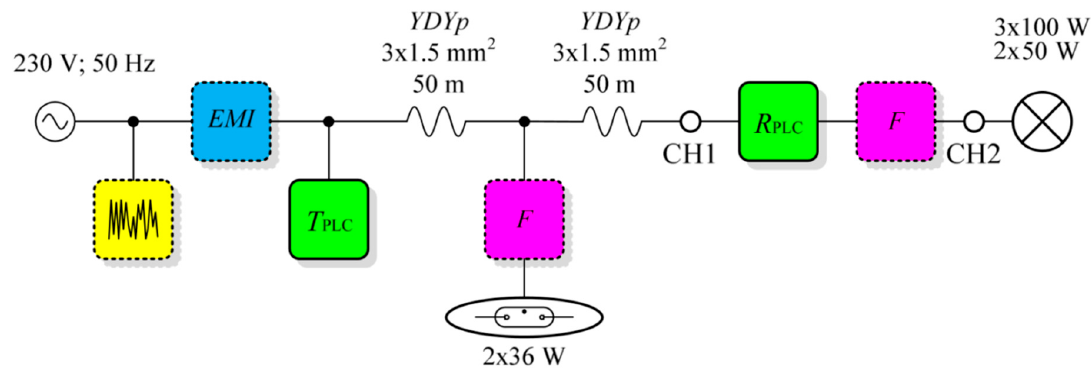
Figure 13. Connection schematic of the model with an EMI filter and an additional receiver connected in the middle of the line by an F filter—Variant 3.